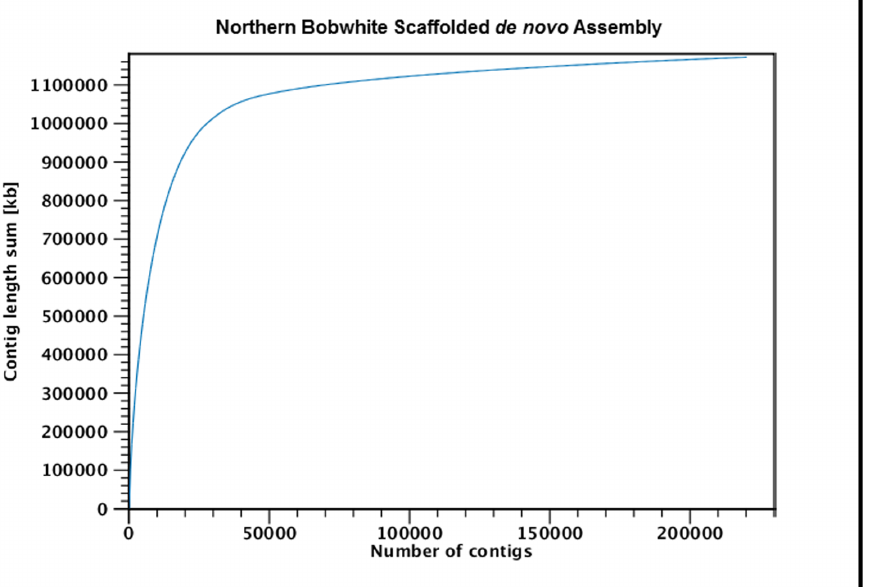
Figure 1. Relationship Between Total Contig Length (Kbp) and Total Contig Number for the Scaffolded Bobwhite ( Colinus virginianus ) Genome (NB1.1). The y-axis represents total contig length, expressed in kilobase pairs (Kbp), and the x-axis represents the total number of scaffolds. The bobwhite genome was estimated to be 1.19–1.20 Gbp. For NB1.1 (1.172 Gbp), . 90% of the assembled genome was captured within , 40,000 scaffolds.